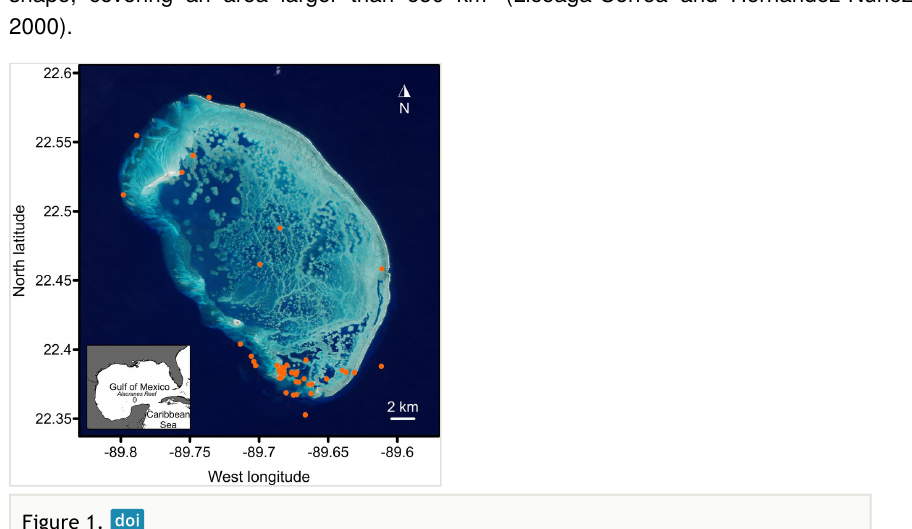
Description: The dataset contains information on 110 species (93 nominal species and 17 generic species), belonging to 71 genera, 33 families and three suborders. The suborder Amphilochidea was composed of 46 species, 28 genera and 13 families, the suborder